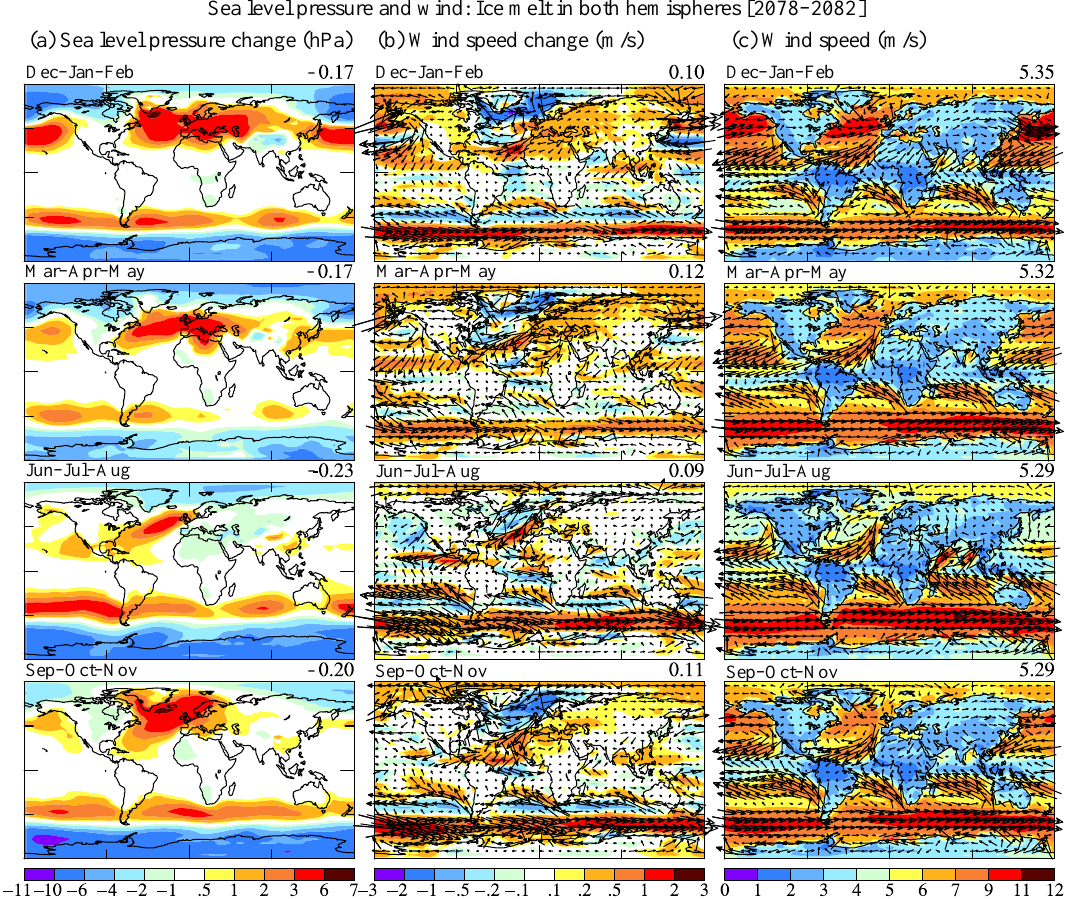
Figure 20. Change of seasonal-mean (a) sea level pressure (hPa), (b) wind speed (ms − 1 ) in 2078–2082 relative to 1880–1920, and (c) the wind speed (ms − 1 ) itself, all for the scenario with ice melt in both hemispheres.